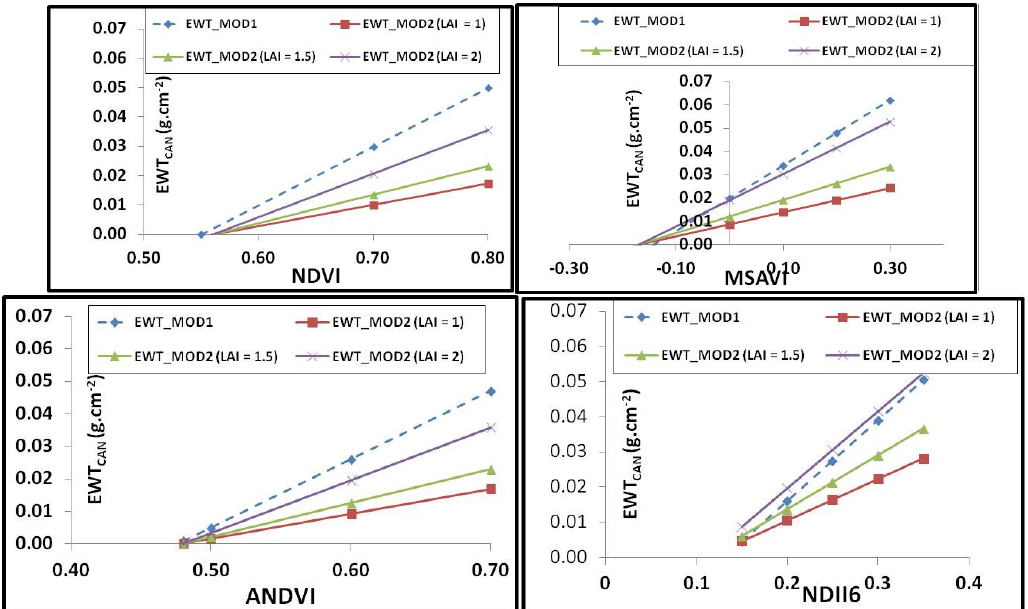
Figure 5. Relationship between EWT CAN_FILED from field measurements and modeled EWT CAN from the different VI from MOD1 (black dots) and MOD2 [red dots]). 1:1 line is shown [black line] (EWT CAN are in g∙cm −2 ).